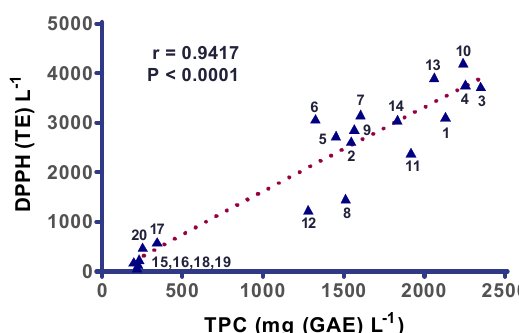
Figure 5. Correlation between TPC (total polyphenols content) and antioxidant capacity as assessed by DPPH assay in red ( n = 14), rosé ( n = 3) and white wines ( n = 3) bought in a Belgian commercial market.